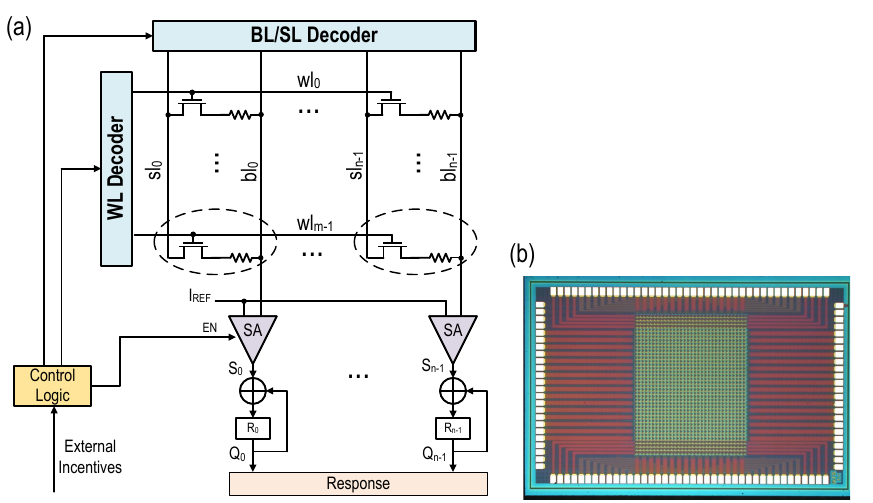
Figure 2. ( a ) Structure of proposed RRAM PUF circuit. ( b ) Microphotograph of the fabricated RRAM array